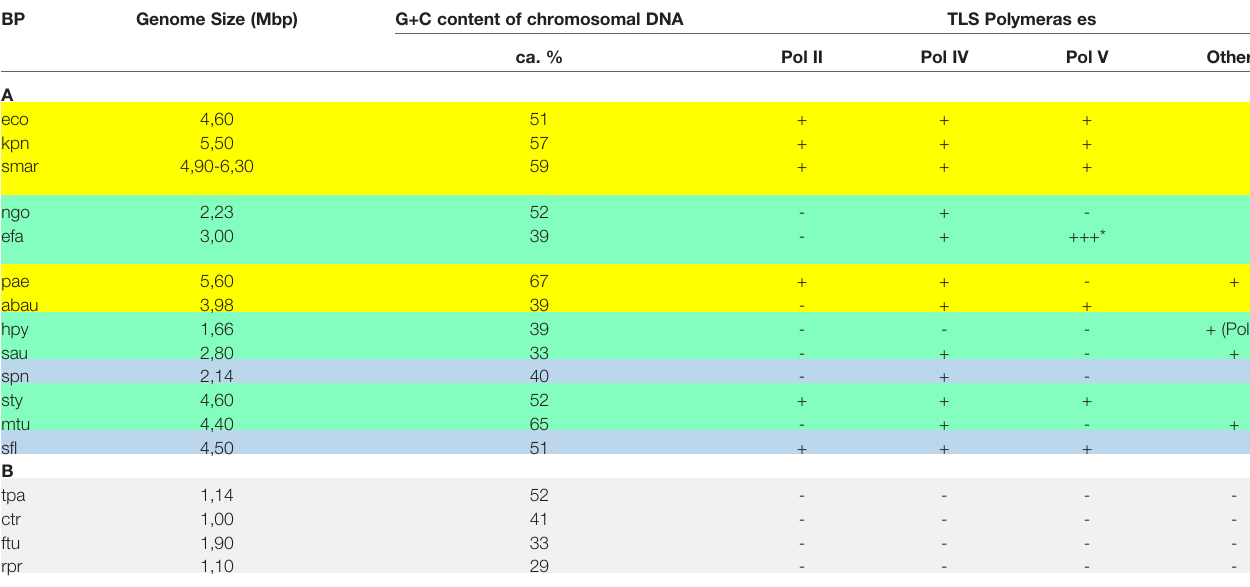
(A) Bacterialpathogens(BP)withthehighestfrequencyofABR;(yellow):priority1,(green):priority2,(blue):priority3; (B) BacterialpathogenswithlowfrequencyofABR.Forabbreviations, see legend to Table 1 and